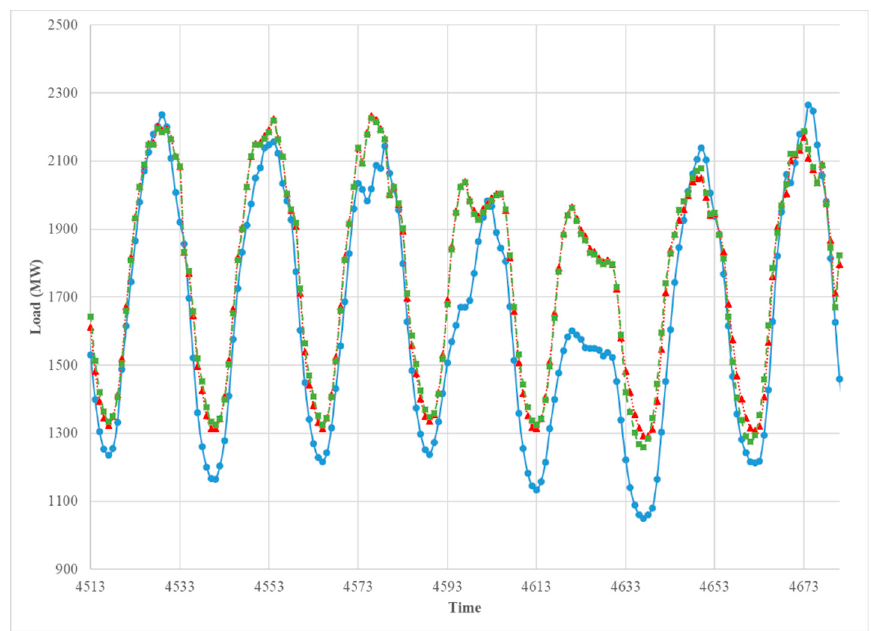
Figure 12. The comparison between the observed hourly load (blue solid), the predicted hourly load of Model 1 (red doted), and Model 2 (green dashed). 1 April 2013–7 April 2013.